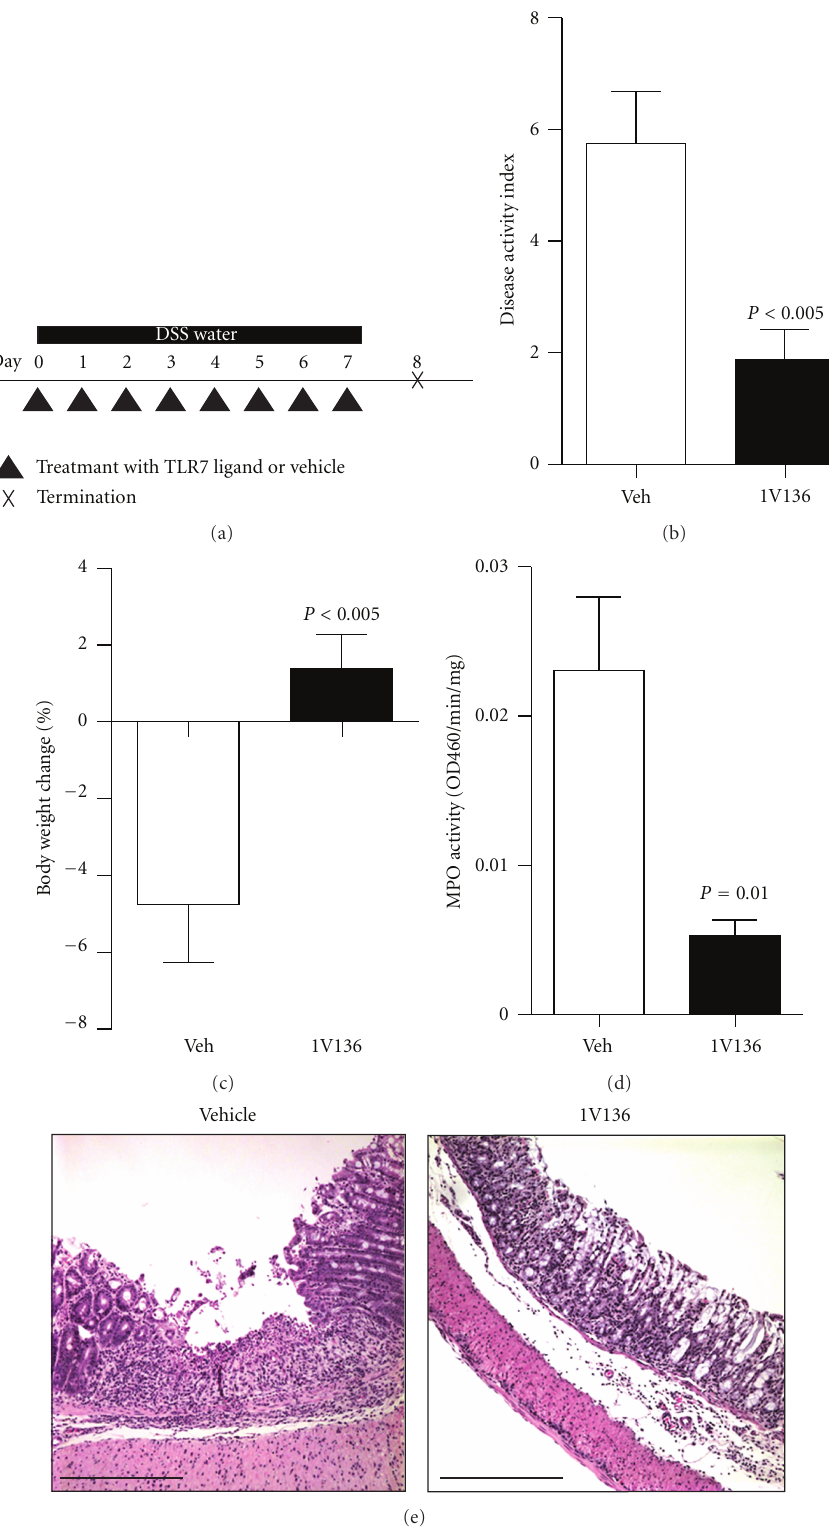
Figure 1: TLR7 ligand hyposensitization reduces the inflammation of DSS-induced experimental colitis. (a) Experimental protocol of induction of DSS-induced colitis and treatment regimen. WT mice ( n = 5) received 2% DSS for 7 days. Mice were s.c. treated with 150 nmol 1V136 or vehicle. (b) Disease activity index, (c) percent body weight changes, and (d) MPO activity of colonic tissue was determined as described in Section 2. Data are expressed as means ± SEM and are representative of 2 independent experiments. ∗ Denotes P < 0 . 05 by Mann-Whitney test. (d) Examples of colons of vehicle- or 1V136-treated colitis mice that were removed and prepared for histological examination. Original magnification is × 100. Calibration bar: 100 μ